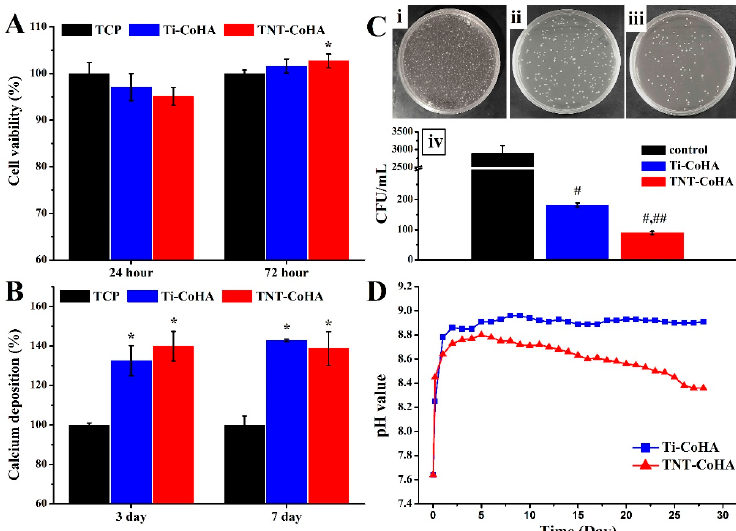
Figure 7. ( A ) Cytotoxicity test using MG63 cells. ( B ) Quantitative analysis of matrix deposition mineralization was performed at 3 and 7 days. ( C ) Images of the antibacterial results for relatively bacterial colonies on agar plates: (i) control (brain–heart infusion (BHI)), (ii) Ti ‐ CoHA, (iii) TNT ‐ CoHA, (iv) antibacterial activity of the analyzed sample on E. coli. ( D ) The pH values of different Ti ‐ CoHA and TNT ‐ CoHA materials soaked in PBS solution. (*: Significantly higher than the control group (tissue culture plate (TCP)), #: Significantly lower than the control group (BHI), ##: Significantly lower than other groups, p < 0.05, mean ±SD, n = 4).